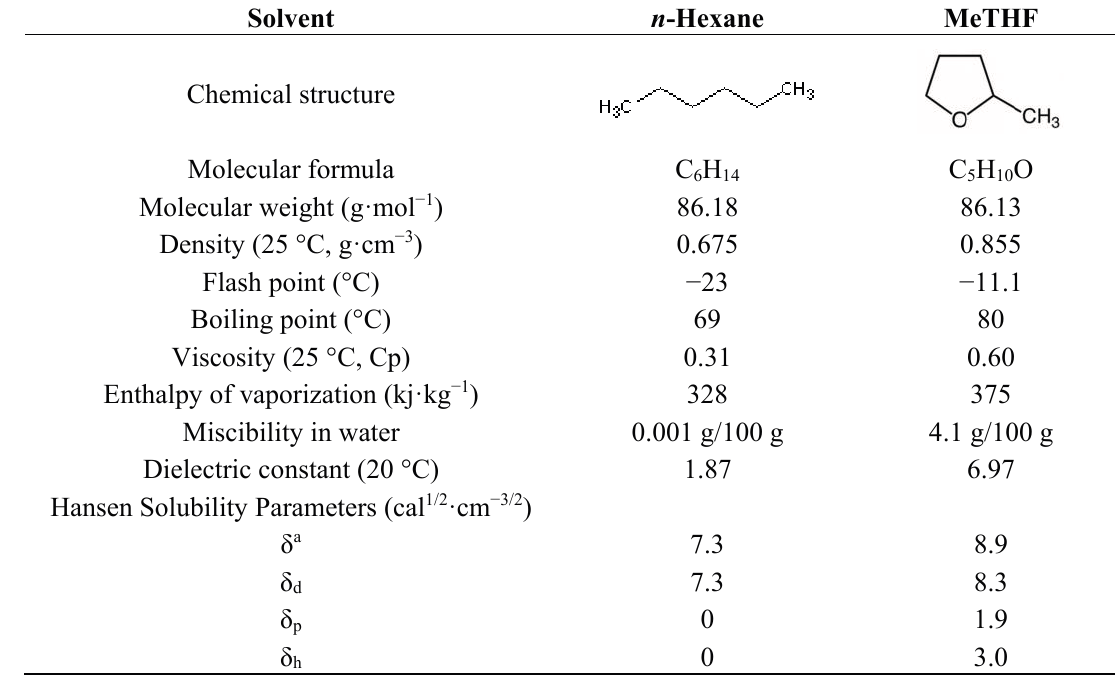
Table 1. Properties of n -hexane and